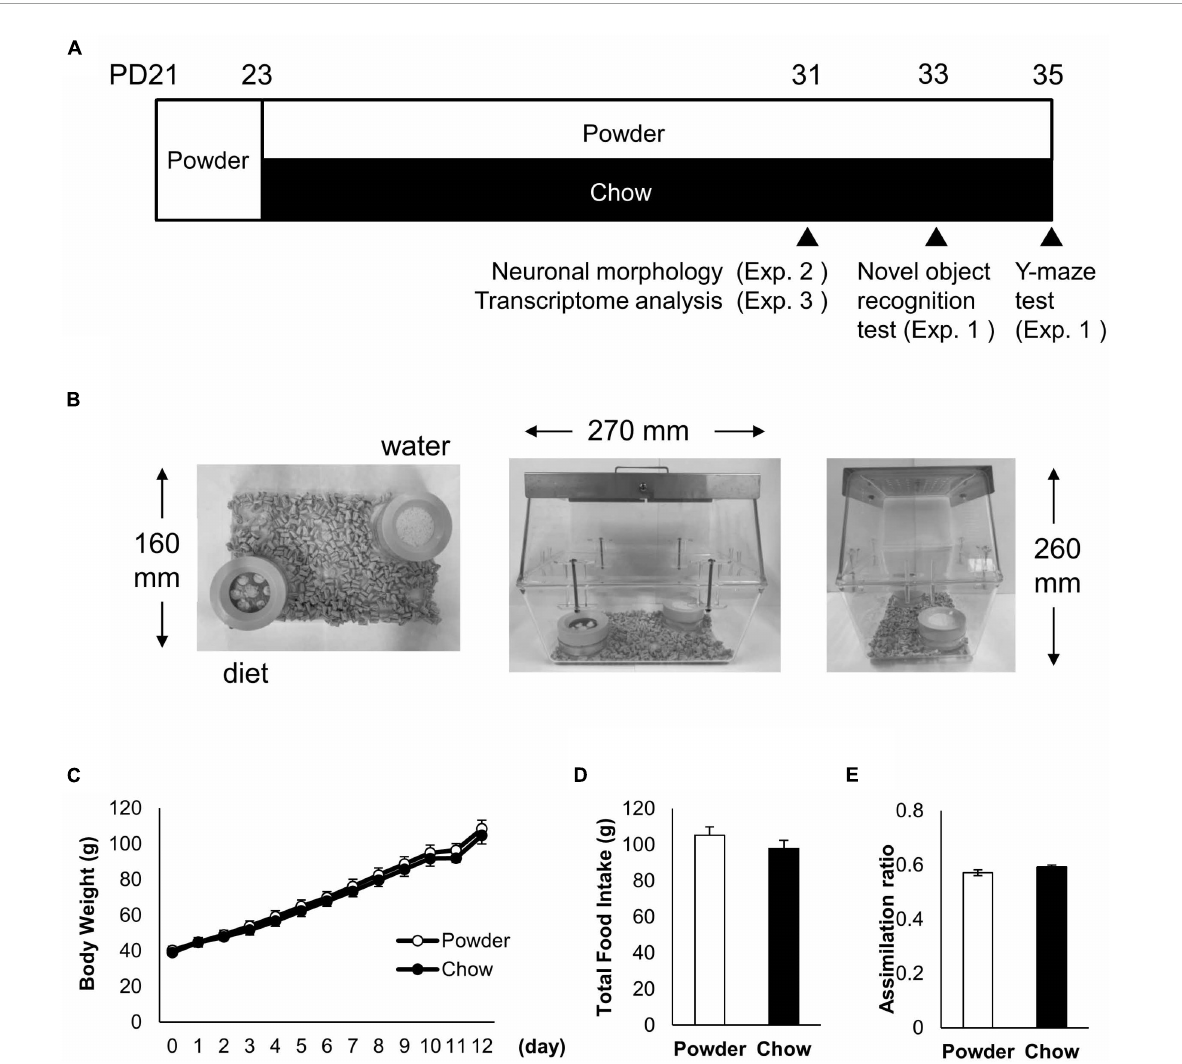
FIGURE1 Raising condition and physical parameters of the rats. (A) Raising schedule and time points of the behavioral test and tissue sampling. Three-week old (PD21) male rats were acclimatized by feeding a powdered diet and separated into two experimental groups, fed powdered diet (P-group) and chow diet (C-group), respectively. Three independent experiments (Exp. 1 to 3) were conducted for different analyses. (B) Raising condition of the rats. Two containers with plastic lids were located symmetrically in the cages made with polycarbonate buckets and metal lids. (C) Time course of average body weight in Exp. 1 ( n = 8 for each group). (D) Total food intake from day 2 to 10 in Exp. 1. (E) Assimilation ratio from day 2 to 10 in Exp. 1. No significant difference in physical parameters was detected between the experimental